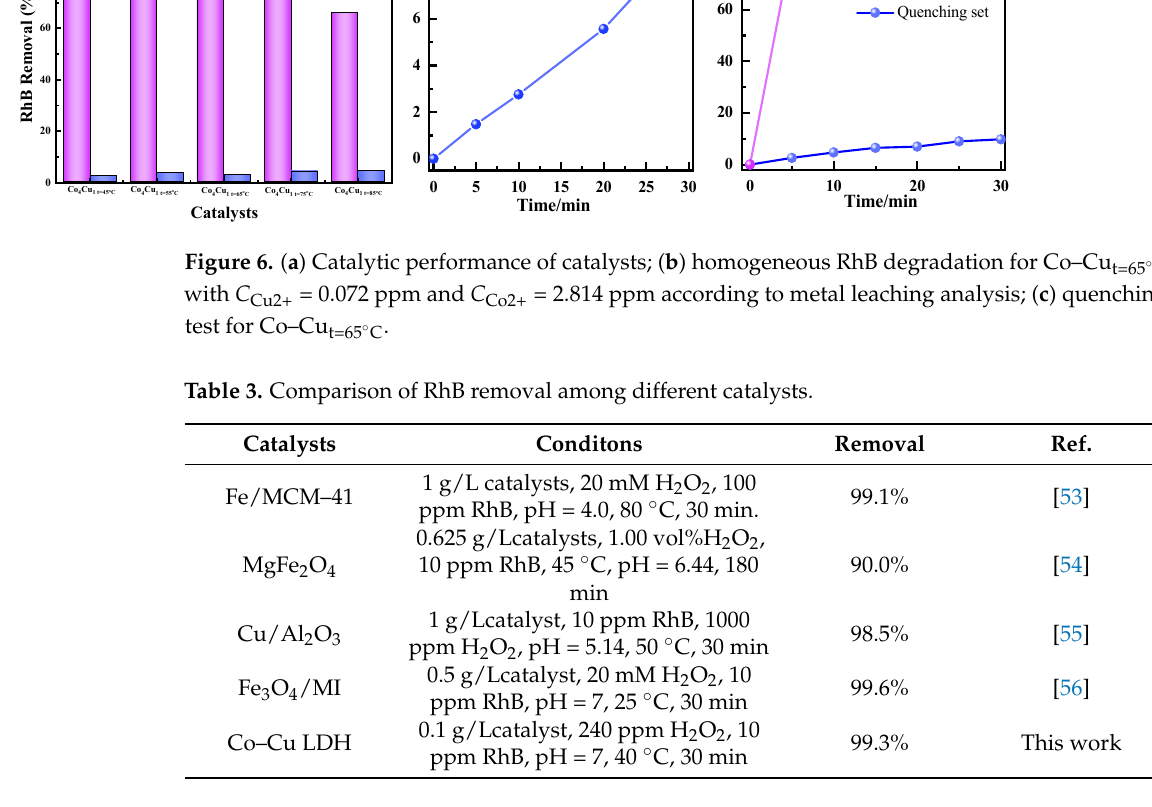
Table 3. Comparison of RhB removal among different catalysts.